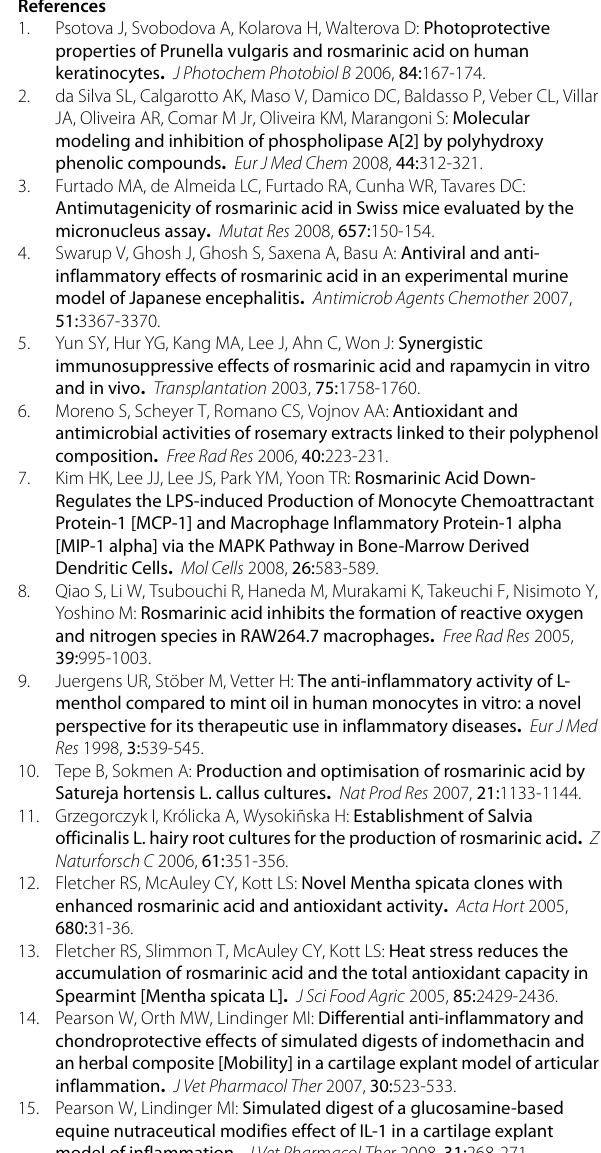
Additional file 1 Table: Effects of 24-hour LPS treatment [0 or 3 μg/ mL] on explants conditioned with CM sim , RA, CO, CA, and FA, and unconditioned control